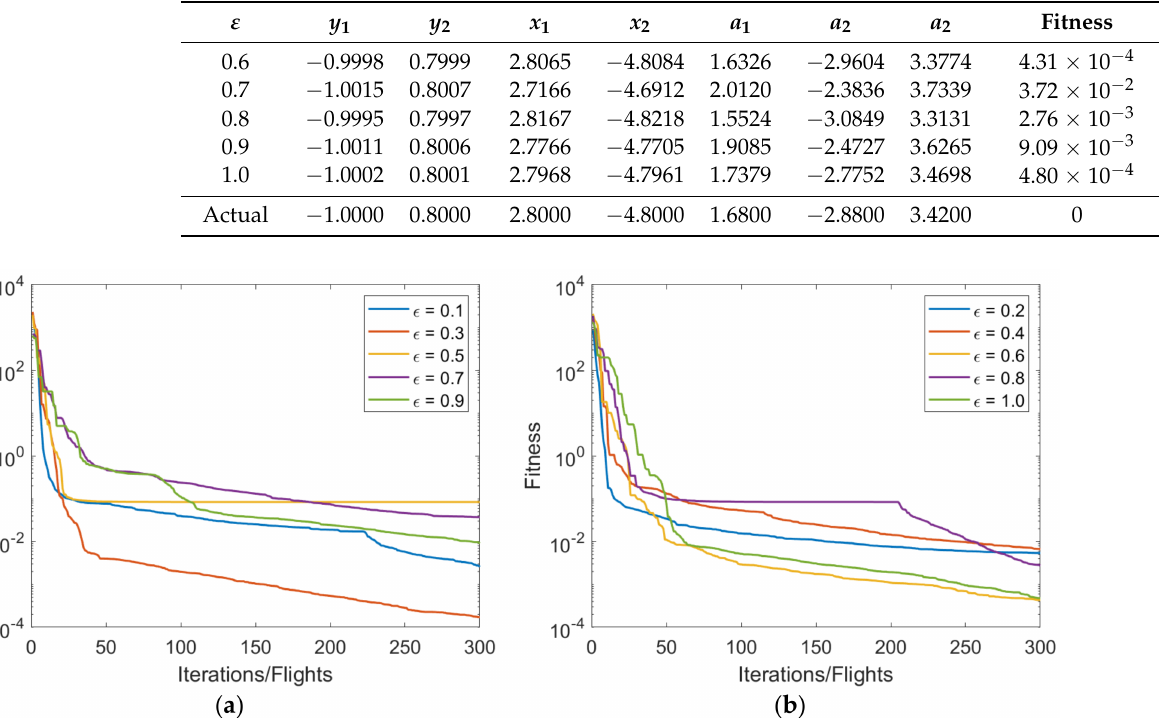
Table S4. Parameter estimates with level of estimation accuracy for ε = 0.6. Table S5. Parameter estimates with level of estimation accuracy for ε = 0.7. Table S6. Parameter estimates with level